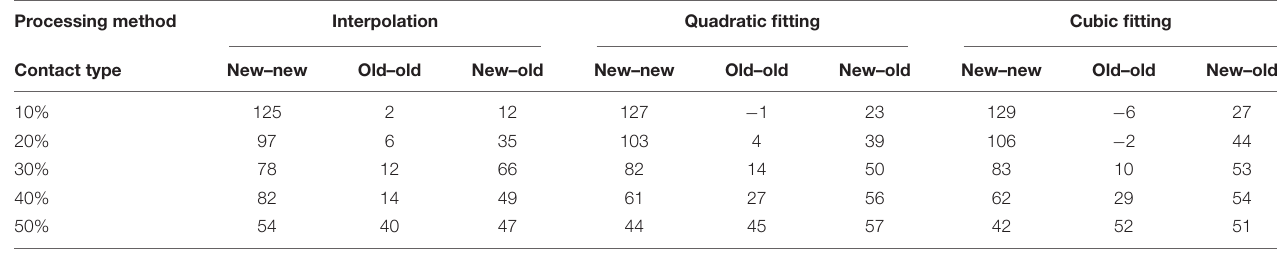
FIGURE 5 | Statistics of the number of contact points. TABLE 8 | Data processing.